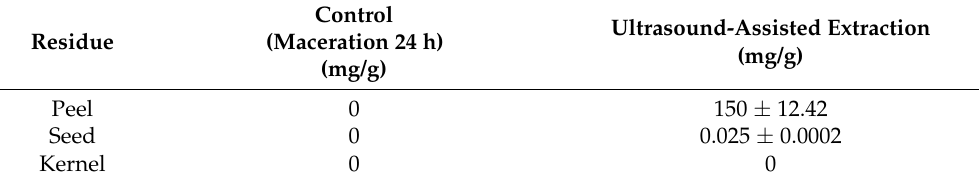
Table 3. Quantification of mangiferin in different residues by ultrasound-assisted and maceration